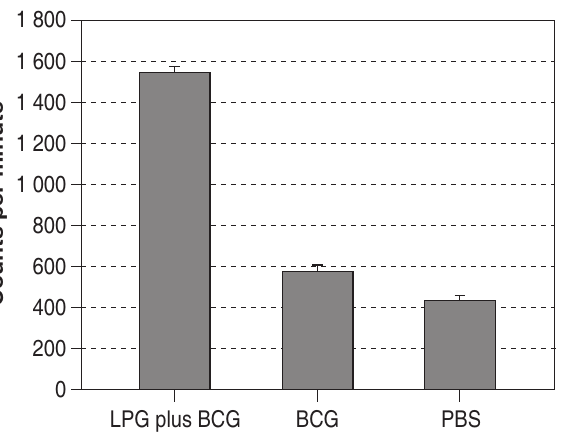
FIG. 3 Lymphocyte proliferation responses in hamsters immunized with LPG plus BCG, BCG or PBS controls